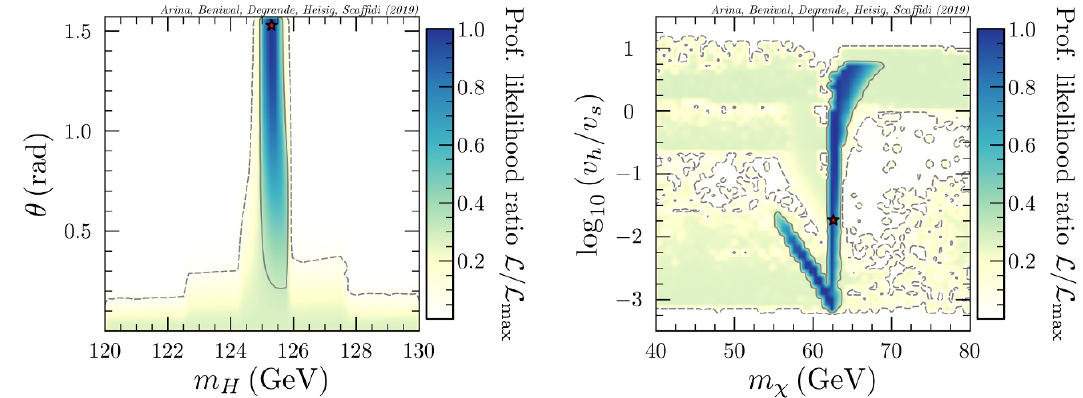
Figure 2 . 2D PLR plots from our global (cid:12)t in the ( m into the region m H m h and the resonance region, m (cid:31) (cid:24)